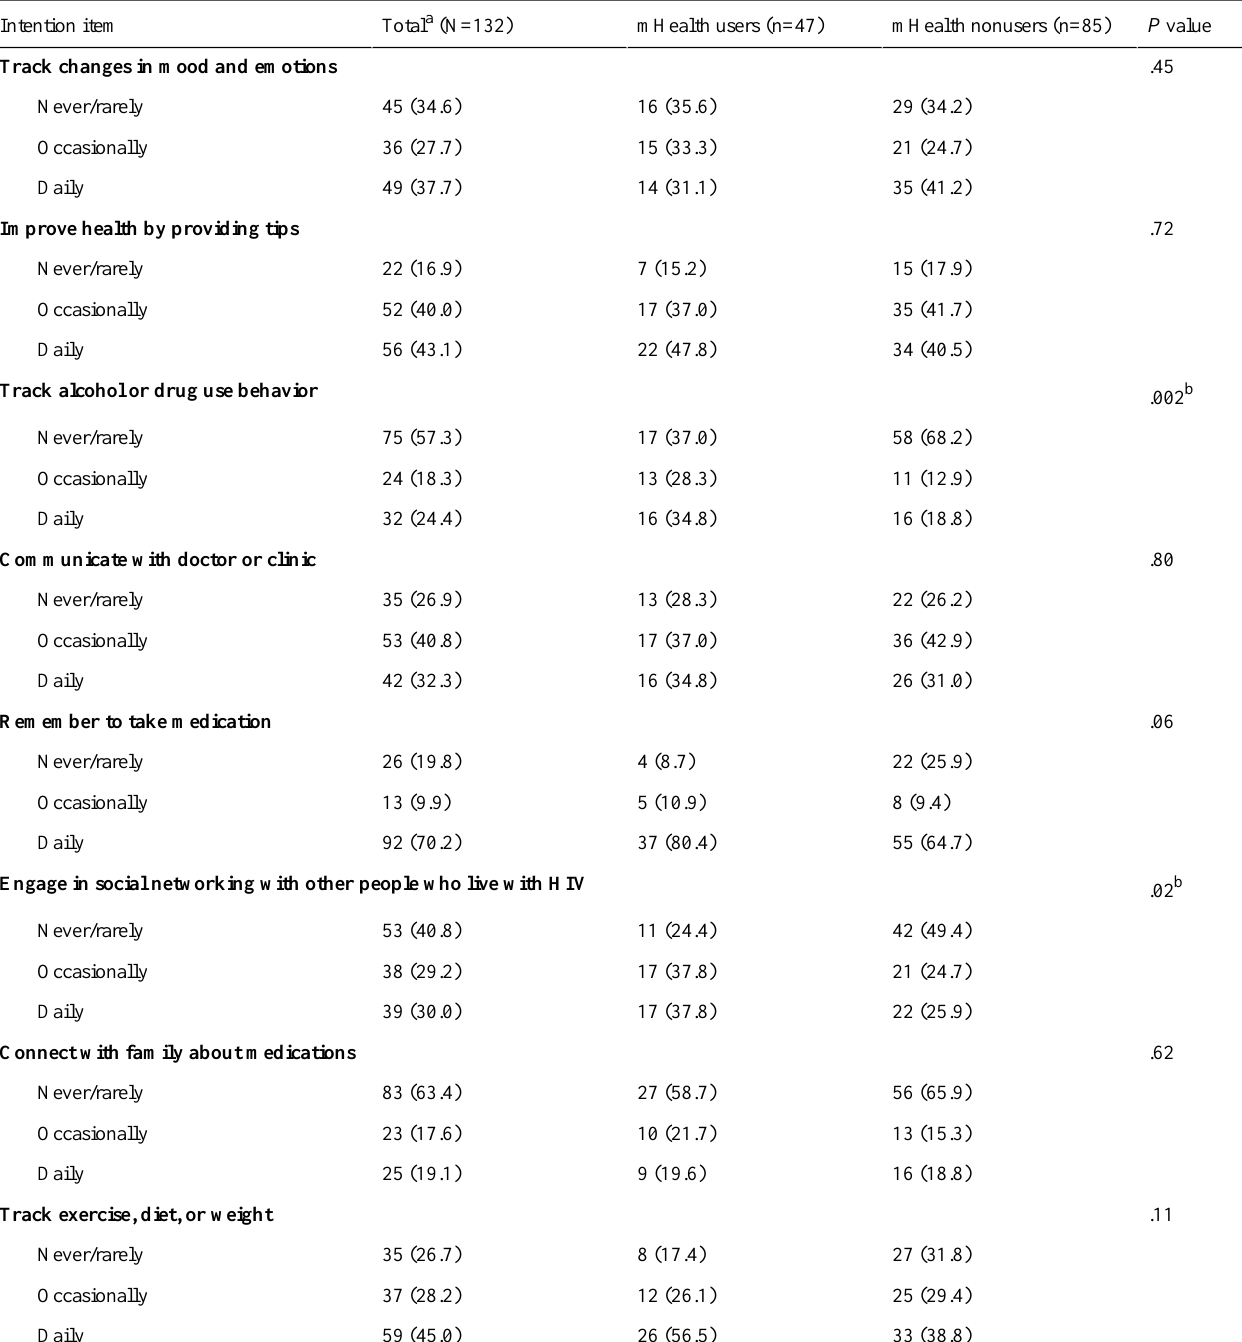
Table 4. Baseline behavioral intent regarding use of a mobile health platform to enhance other forms of health promotion among people living with HIV/AIDS (PLWH) enrolled in the Florida mHealth Adherence Project for PLWH Study, 2015-2016 (N=132). The responses are to the question, “If available and free, how often would you use a phone app to help